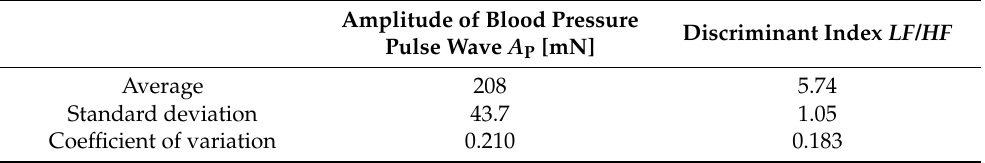
Table 1. Comparison of the variability between the amplitude of blood pressure A P and discriminant index LF / HF